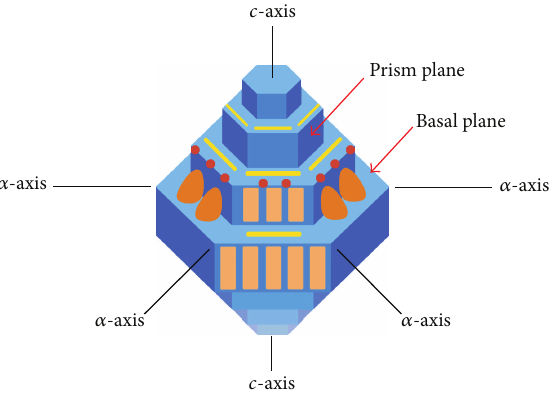
Figure 2: Potential interactions of antifreeze proteins on ice crystal surfaces. Antifreeze proteins (non-blue objects) bind to two major planes: prism and basal plane. Location of binding is dependent on the protein characteristics. Antifreeze proteins bound to the prism plane inhibit ice growth along the 𝛼 -axes, but when bound to the basal plane c -axis ice growth is inhibited. Adapted from Kawahara